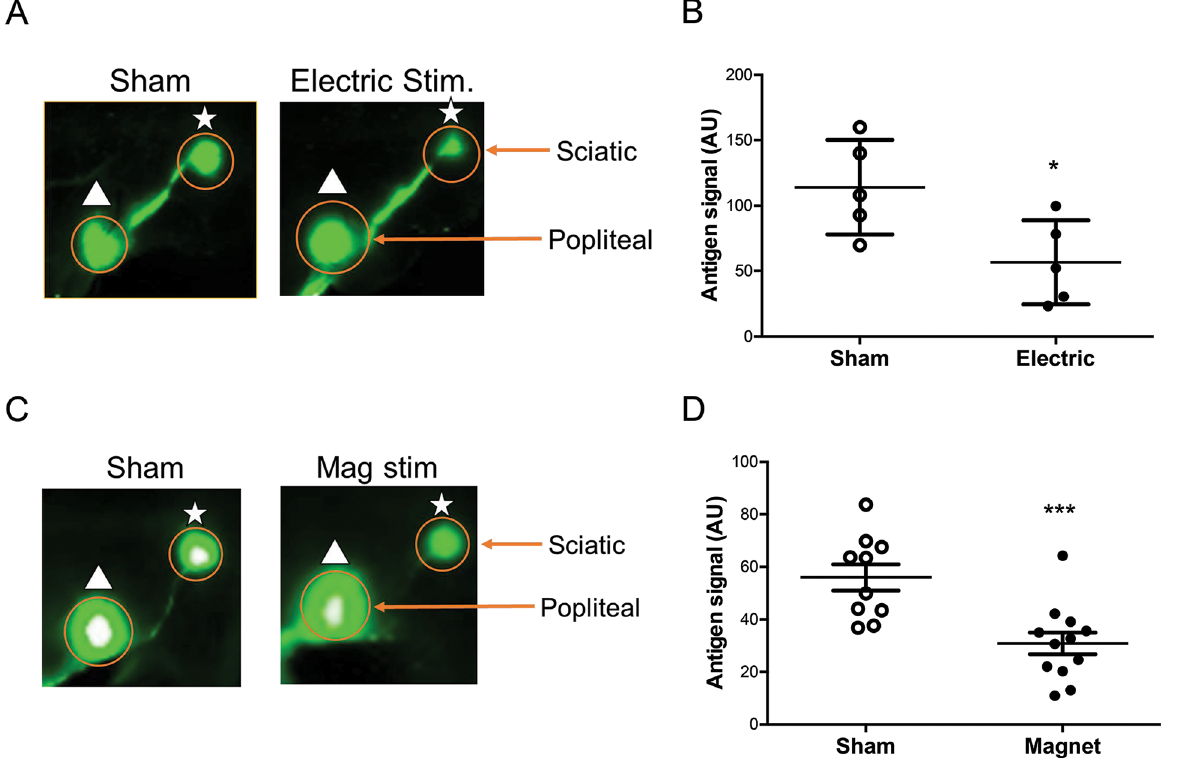
Figure 4. Stimulation of neuronal activity restricts antigen flow. (A, B) Electric stimulation of the nerves to the popliteal and sciatic lymph node restricts KLH-800CW flow to the sciatic lymph nodes (sham, 114.1 ± 16.17, n = 5 versus electrically stimulated, 56.76 ± 14.38, n = 5, p < .05 by t test). (A) Images are representative. (B) Antigen signal in the sciatic lymph node in individual animals is shown here. (C, D) A noninvasive magnetic field was applied to the hind legs of naïve mice to induce nerve activity, followed by injection of KLH-800CW. In magnetically stimulated animals, lower levels of antigen were observed in the sciatic lymph nodes (sham, 55.99 ± 4.993, n = 10 versus magnetically stimulated, 30.87 ± 4.169, n = 12, p < .001 by t test). (C) Images are representative; triangles indicate popliteal lymph nodes and stars represent sciatic lymph nodes. (D) Antigen signal in the sciatic lymph node in individual animals is shown